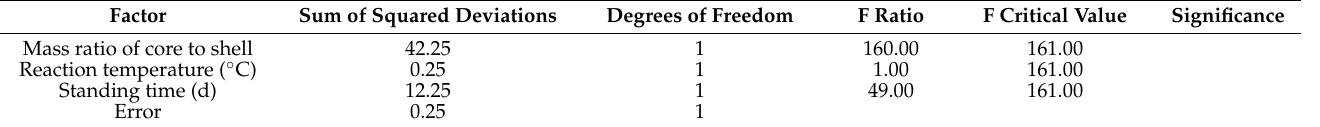
Table 7. Variance results of microcapsule clad ratio by the orthogonal